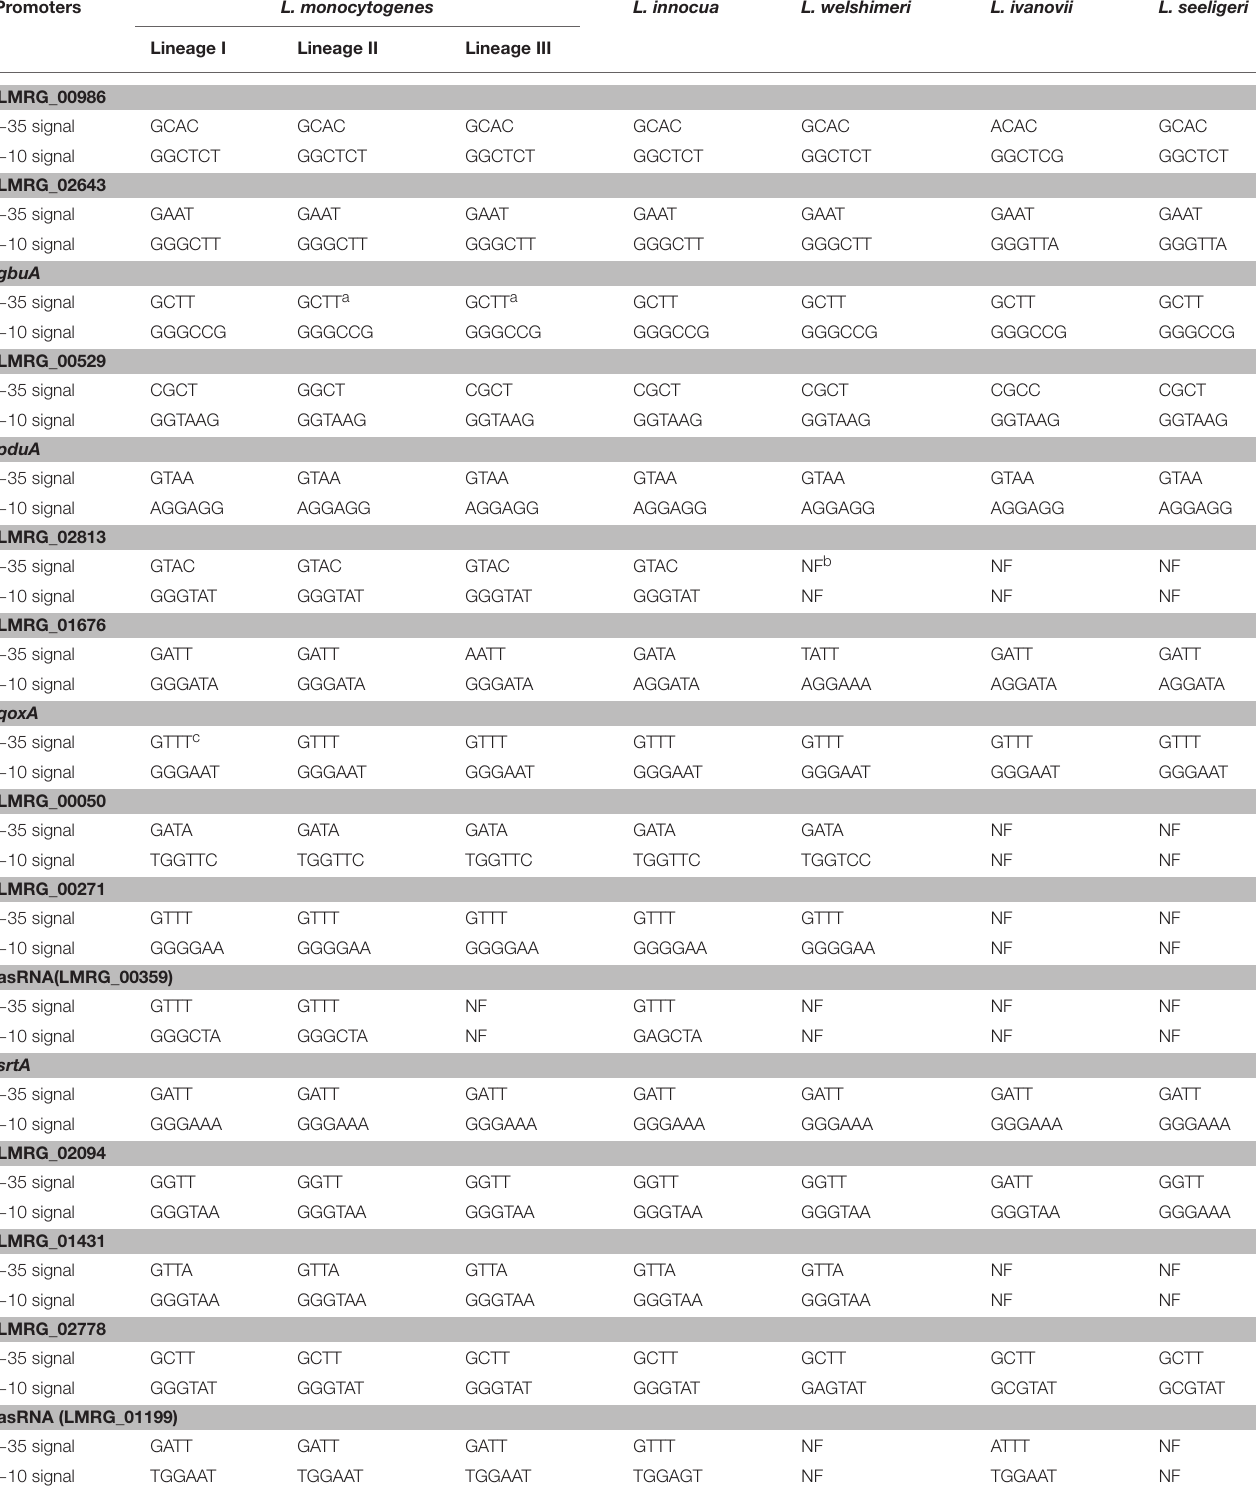
TABLE 4 | σ B -dependent − 35 and − 10 promoter regions for the newly identified σ B -dependent operons.